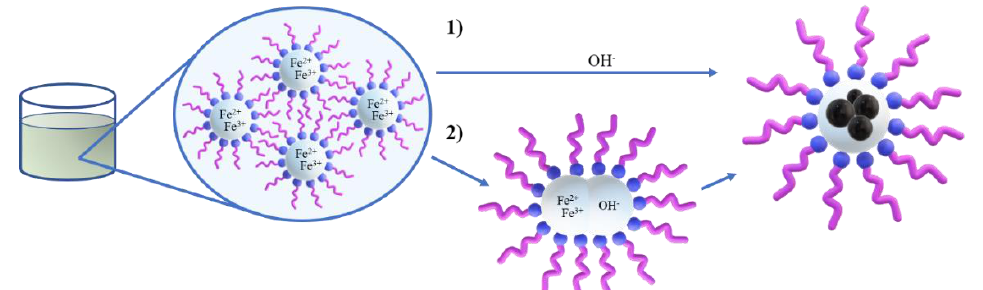
Figure 8. Schematic view of the synthesis of the magnetic nanoparticles studied. Water-based solutions of the iron precursors are used to form a microemulsion in the oil phase. The precipitation of the particles is achieved by means of the dropwise addition of either ( 1 ) the basic ammonia solution or ( 2 ) another microemulsion containing the ammonia.